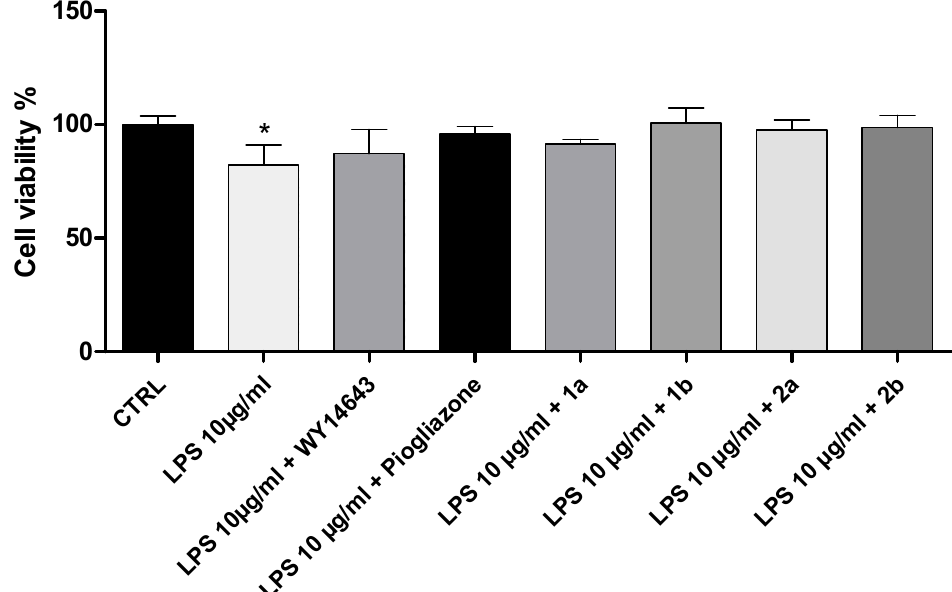
Figure 3. An MTT assay of LPS-pretreated human fibroblast (HFF-1) cells, exposed to WY-14643 (1 µ M), pioglitazone (1 µ M), 1a (1 µ M), 1b (1 µ M), 2a (1 µ M), and 2b (1 µ M), for 24 h. Data were reported as means ± SEM. The results were analyzed by analysis of variance (ANOVA) followed by the Newman–Keuls post-hoc test. ANOVA, p < 0.01; * p < 0.05 vs. CTRL. in hepatocytes increased in acute liver failure [47]. Compared to LPS treated